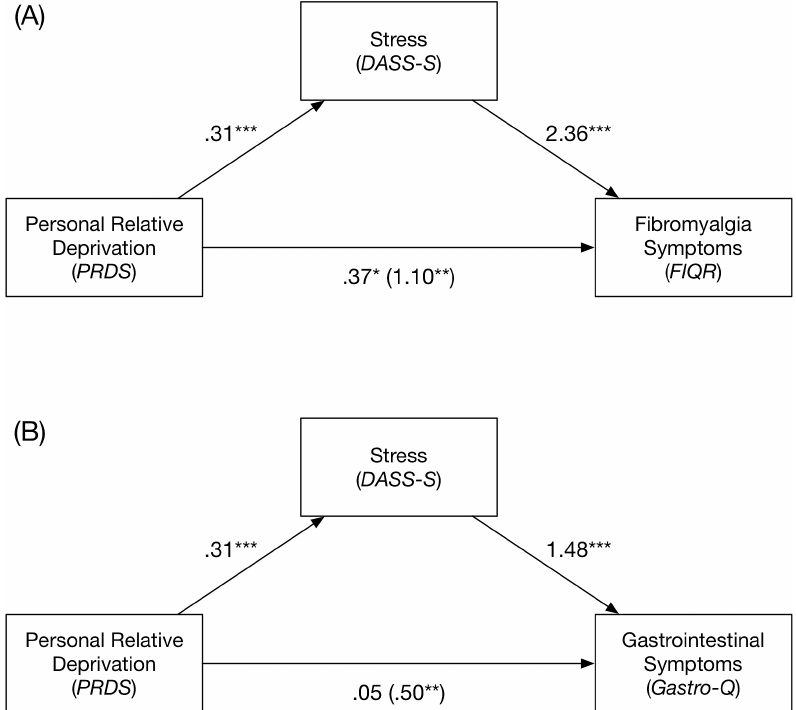
Fig 1. Bootstrapped mediationmodels of the mediatingeffect of stress in the relationshipsof personal relativedeprivationand fibromyalgia symptoms (A), and personalrelative deprivation and gastrointestinal symptoms (B). Stress partially mediatedthe relationshipof personal relative deprivation and fibromyalgia symptoms, and fully mediatedthe relationshipof personalrelative deprivation and gastrointestinal symptoms.